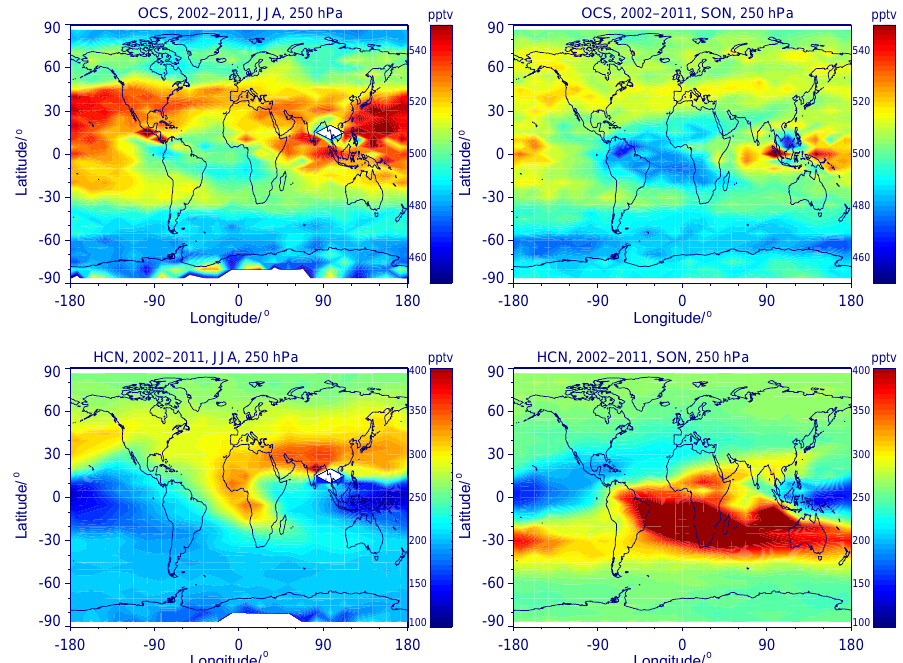
Figure 11. Top row: OCS distribution measured by MIPAS between 2002 and 2011 at the 250hPa level during the periods June to August (left) and September to November (right). Bottom row: same as top panel, but for MIPAS HCN.